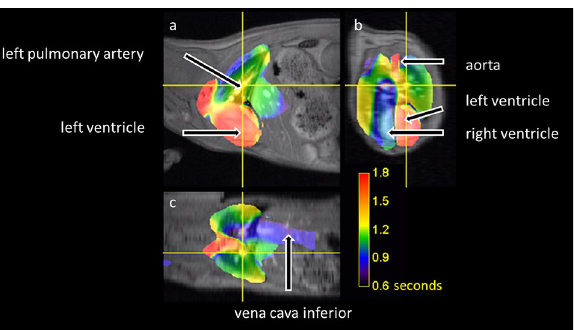
Figure 5. Bolus arrival time map fused with MRI in ( a ) sagittal, ( b ) transversal and ( c ) coronal perspective. The presence of the tracer bolus in the right ventricle starting at about 0.9 s is shown in blue colors and in the left ventricle appears approximately 0.8 s later in red color. Lung perfusion is shown in green and yellow colors representing the time interval in between.